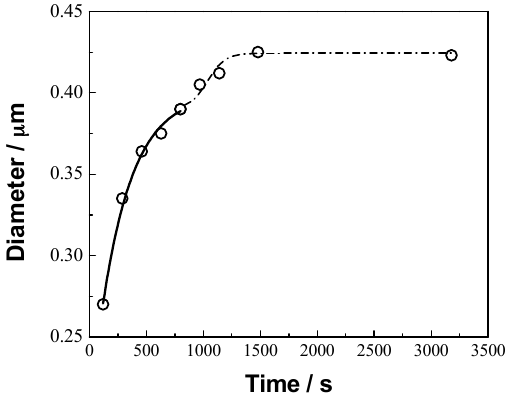
Figure 4. Stimulus-responsive dynamics of the pore size of the PS– b –PAA microporous solid thin film was observed by in-situ AFM in pH = 4.6 buffer solution. The solid line corresponds to a fit with Equation (1), and the dashed line is a fit with Equation (2).